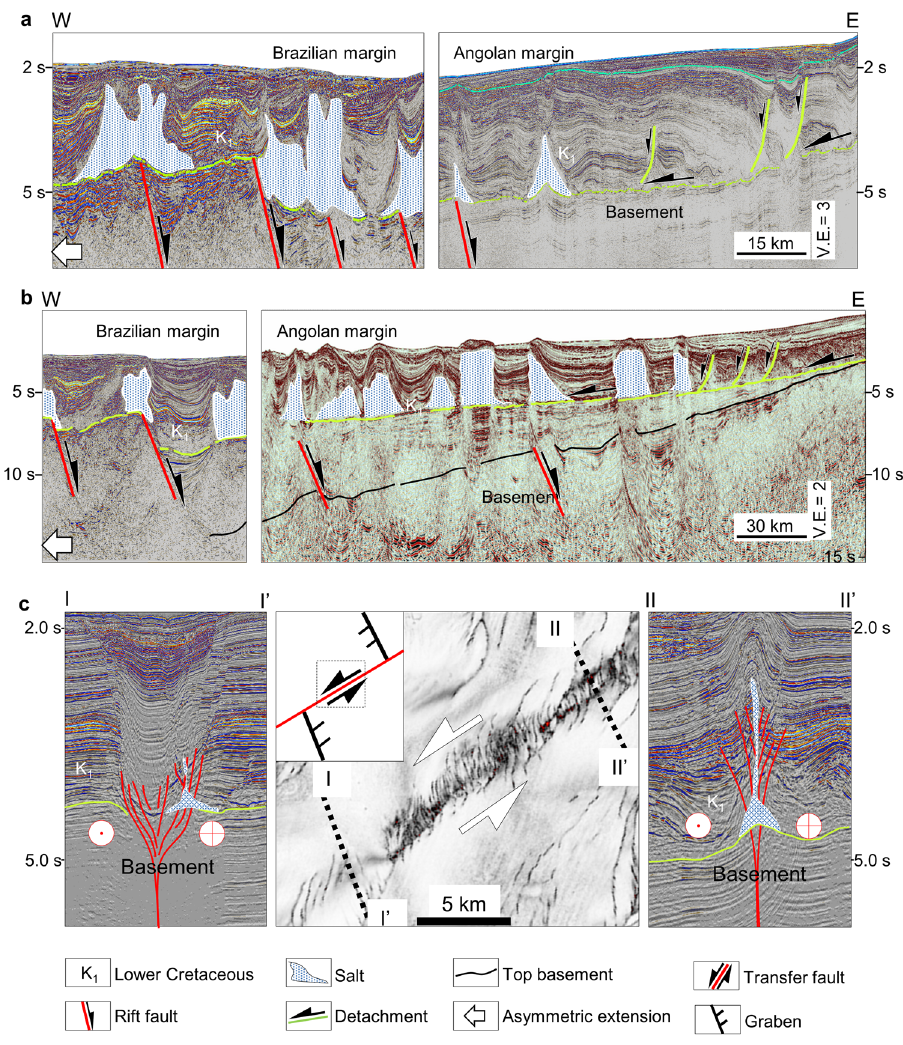
Fig. 2 Seismic image interpretations of a trans-Atlantic asymmetric graben, gravitational slide and transfer fault initially formed in the Early Cretaceous. The approximate locations of seismic lines are shown in Fig. 1b. a Type seismic sections focusing on detachment structures caused by gravitational sliding. b Type seismic sections focusing on asymmetric rift structures causing asymmetric subsidence and thickening of rift sediments. c A reactivated transfer fault at the Angolan continental margin, which is related to the northwest-trending rift faults. Seismic sections (I-I ’ and II-II ’ ) feature a negative fl ower structure (transtension) and a positive fl ower structure (transpression), respectively, both of which are kinematically consistent with the en-echelon pattern of fault